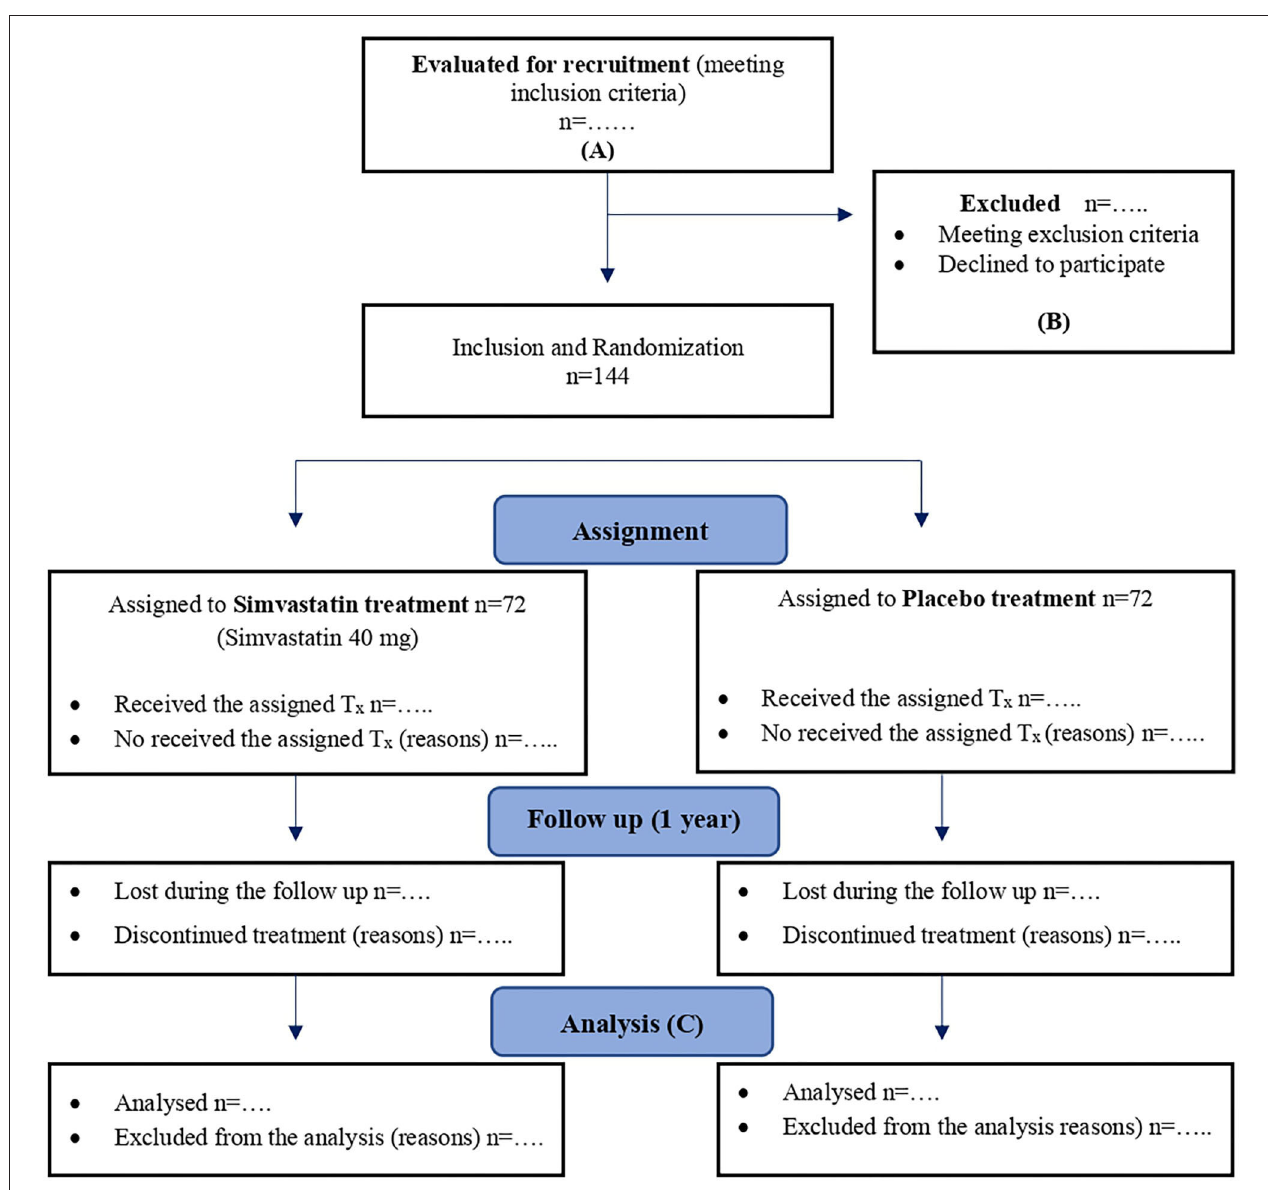
FIGURE 1 | Flowchart for SIMBA trial according to CONSORT 2010 and SPIRIT 2013 recommendations. (A) ≥ 18 years old, at least 2 episodes of AP or acute flares of chronic pancreatitis, written informed consent. (B) < 2 episodes of pancreatitis or acute flares of chronic pancreatitis in the last 12 months; stain consumption in the previous year; contraindications to the use of statins; cholelithiasis or choledocholithiasis diagnosed in the last episode of pancreatitis; endoscopic sphincterotomy and/or cholecystectomy and/or pancreatic surgery between last episode of AP and recruitment or patients who are expected to undergo one of this techniques in less than a year; serum triglycerides > 500 mg/dL without previous specific treatment before the last episode of pancreatitis, or in patients expected to have a change in their specific hypertriglyceridemia treatment in < 1 year; primary hyperparathyroidism that has been operated between last episode of pancreatitis and recruitment or will be operated in < 1 year; iatrogenic pancreatitis; abstinence syndrome due to alcohol or drugs and/or delirium tremens in the last 6 months before recruitment; previous (last year) failure to attend follow-up medical visits, social problems that may be associated to failure to take the medication or to perform an adequate follow-up; pregnancy or breastfeeding. (C) Intention-to-treat (primary analysis) and per-protocol analysis. T x , treatment.